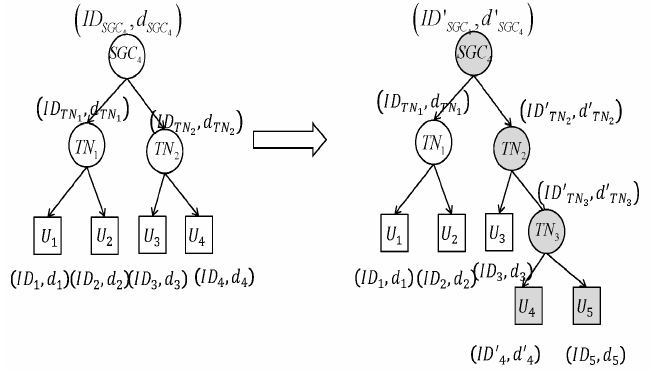
Figure 3. New member